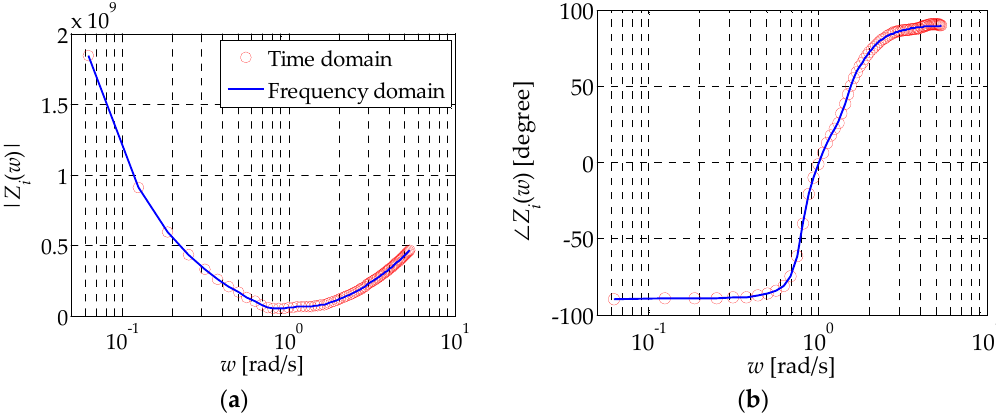
Figure 3. The duck wave-energy converter (WEC) intrinsic mechanical impedance calculated in both the frequency and time domain: ( a ) magnitude of Z i ; ( b ) phase angle of Z i .